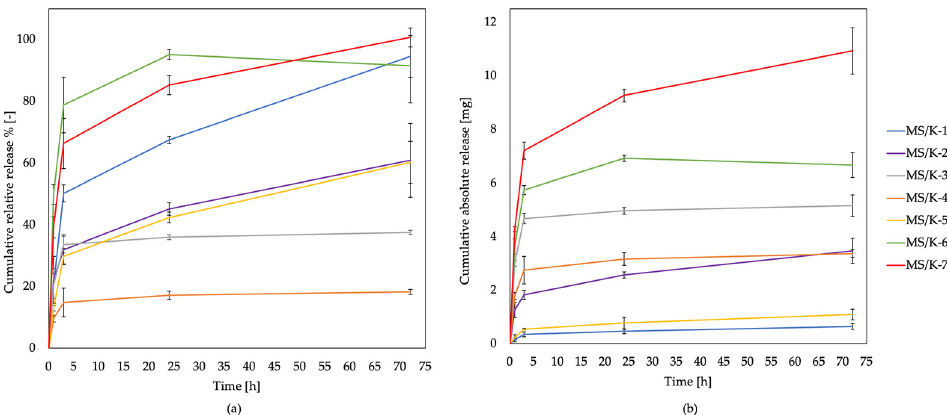
Figure 6. Cumulative relative ( a ) and absolute ( b ) release profiles of LYS from MS/K upon incubation in PBS at 37 °C for 72 h. LYS cumulative release was expressed as the released relative percentage of the total amount of encapsulated LYS or as the absolute weight of LYS released for each sample type. Reported values represent the mean ± SD (n = 6).